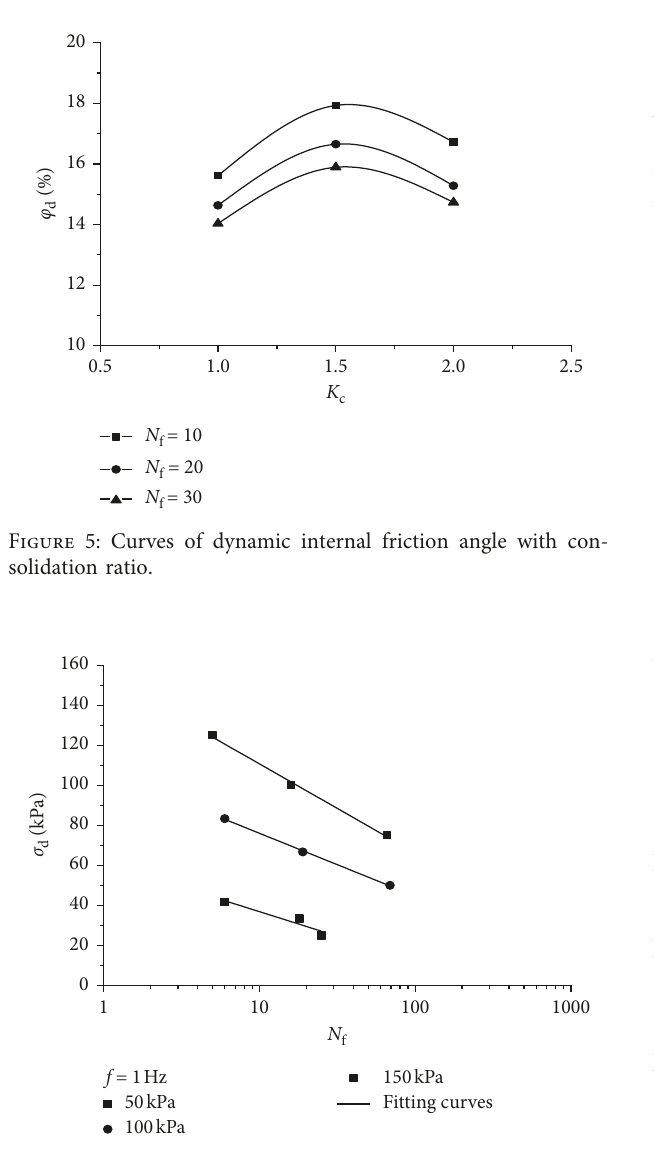
Figure 6: Relationship curves between dynamic strength and failure cycles at different frequencies.